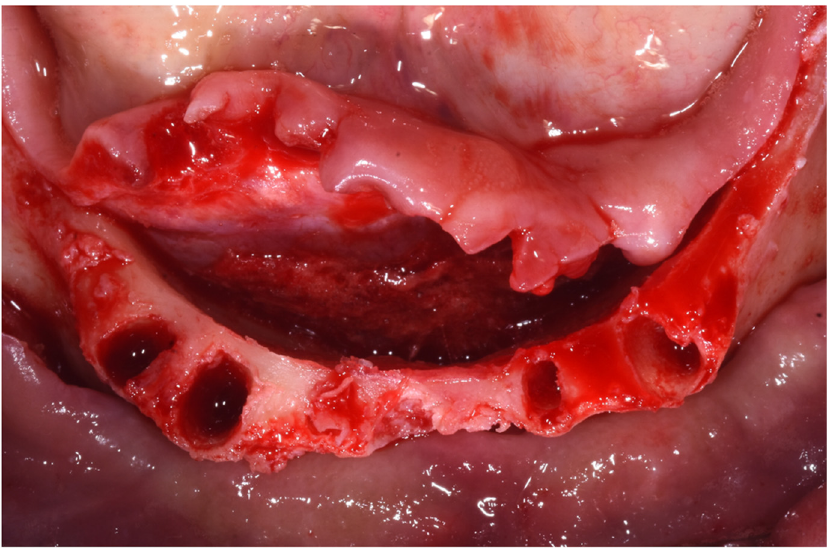
Figure 4. Mucoperiosteal flap elevation after extraction of the hopeless teeth. (March